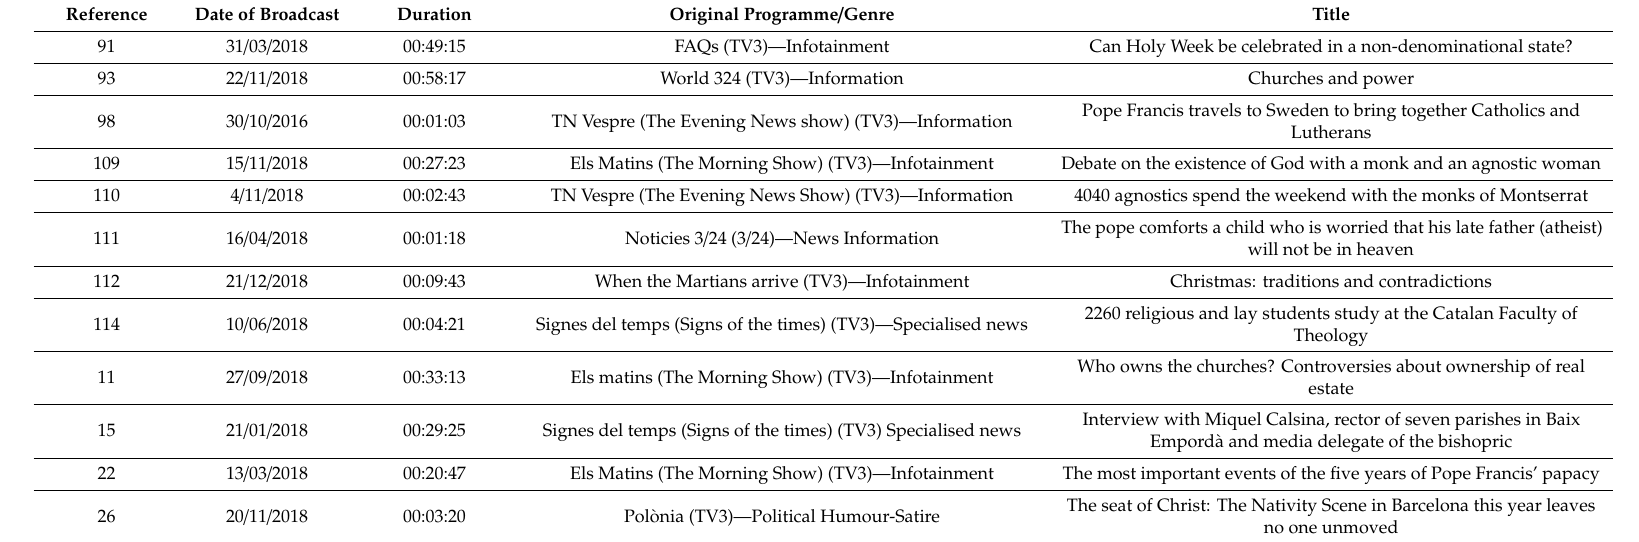
Table 1. Audio-visual material analysed where the perspective of the Catholic religion